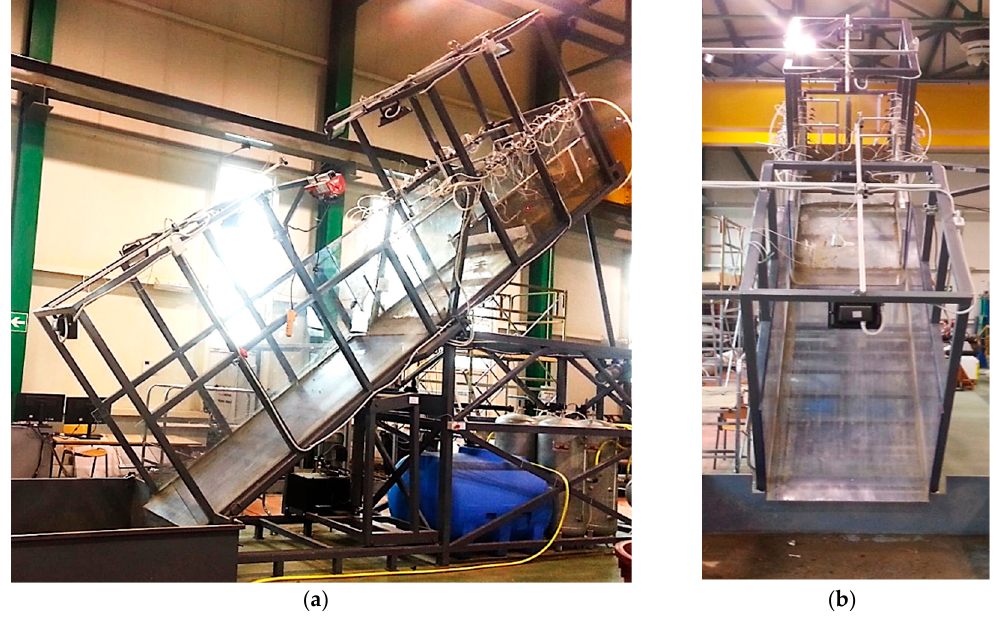
Figure 2. Physical model: ( a ) side view; and ( b ) frontal view.